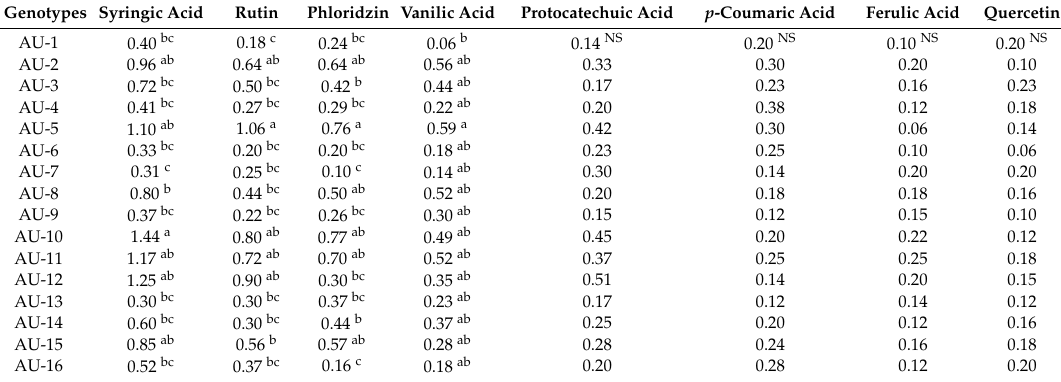
Table 7. Minor phenolic compounds of strawberry tree genotypes (average of 2017–2018 years) (mg / 100 g